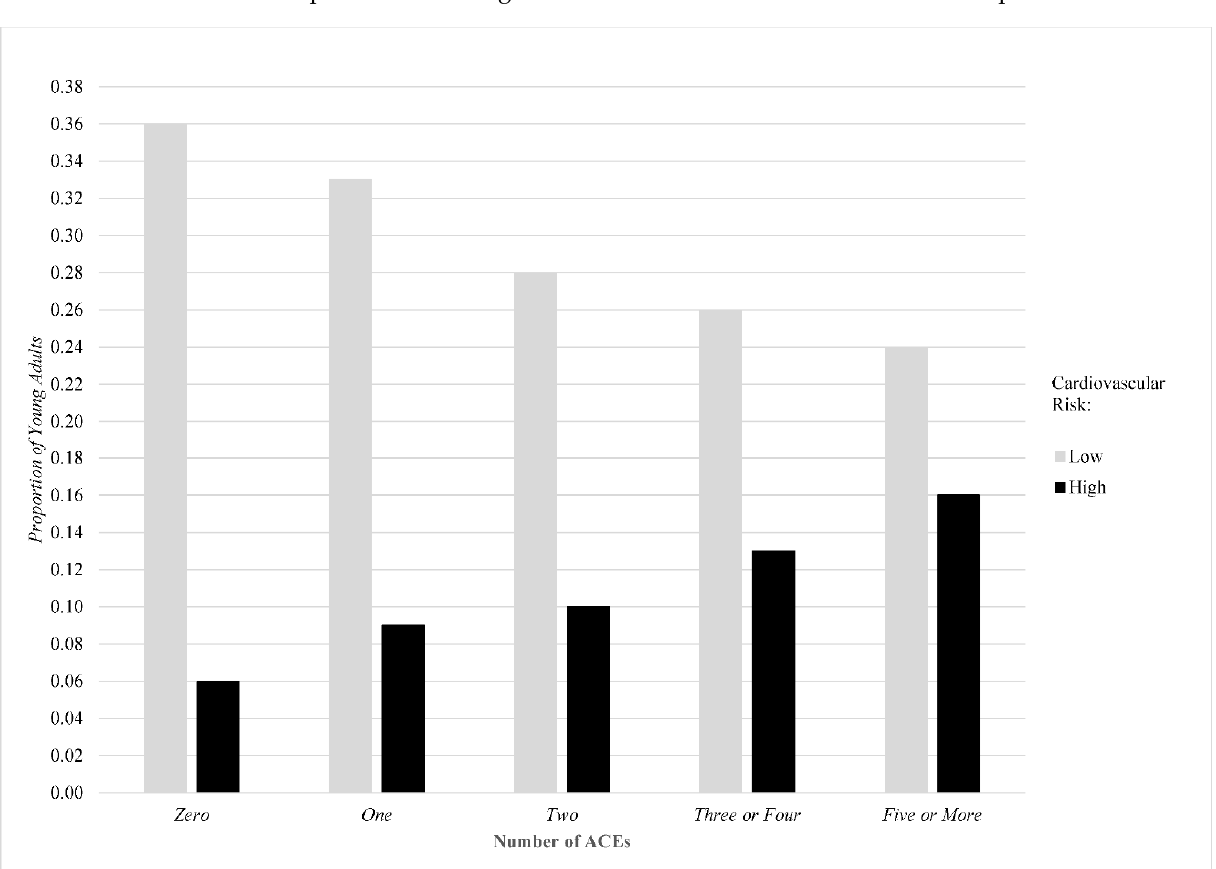
Figure 1. Proportion of young adults exhibiting low vs. high cardiovascular risk by number of ACEs.